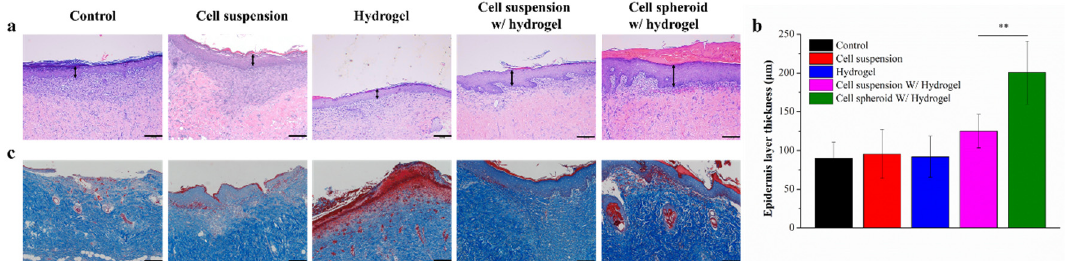
Figure 4. ( a ) Hematoxylin and Eosin (H&E)-stained epidermises from the leading wound edge at 14 days, scale bar: 200 μ m; ( b ) bar graph showing epidermal thickness at 14 days, n = 4, with samples analyzed with one-way ANOVA, ** p < 0.01, and error bars representing mean ± s.d.; and ( c ) representative photographs of the collagen marker (Masson’s trichrome) for wounds treated with different formulations: collagen was stained in a blue color. Scale bar: 200 μ m.